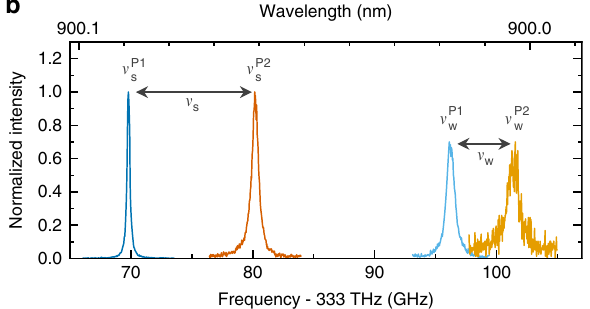
Fig. 8 Experimental setup and high-resolution emission spectra. a Experimental setup showing the coupling beam path (solid red) and the detection beam paths (pale red). Each micropillar laser sample is placed in a cryostat at temperatures of T 1 = 32K and T 2 ∈ [32K, 36K]. Linear polarizers (LinPol) in combination with half-wave plates ( λ /2) are used for mode selection, a variable attenuation (VarAtt) is used to control the mutual coupling strength, and a 50/50 polarizing beam splitter (PBS) directs the pillar emission to the monochromators with attached detectors, which include single-photon counting modules (SPCM) that are used to measure high-resolution spectra by a Fabry – Perot interferometer (FPI) and intensity auto-correlations in a Hanbury Brown and Twiss (HBT) con fi guration or cross-correlations. In addition, 90/10 (90:10) beam splitters are used for white light illumination and monitoring of the sample surface. b Fabry – Perot interferometer (FPI) spectra of the noncoupled micropillar lasers P1 and P2. The strong mode and weak mode (respectively normalized to 1 and to 0.7) are depicted in the same color-coding as used in Fig.